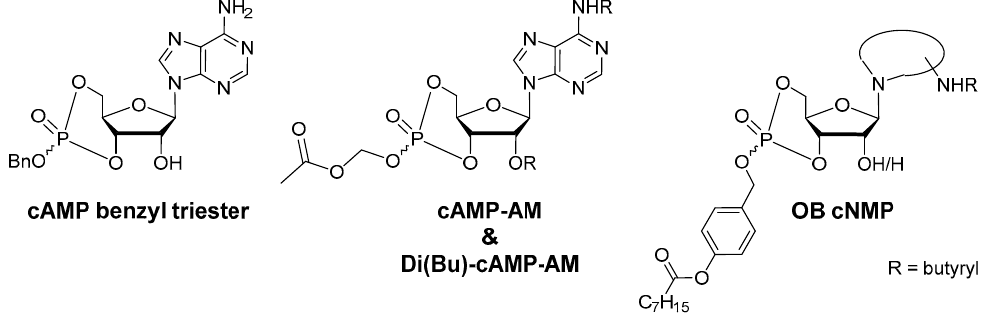
Figure 1. Masked cAMP derivatives. Left: Benzyl triesters of cAMP reported by Engels et al. [8,9]. cAMP-AM derivatives introduced by Schultz et al. (middle [12,13], Right: structure of the OB-masked cNMPs disclosed here.